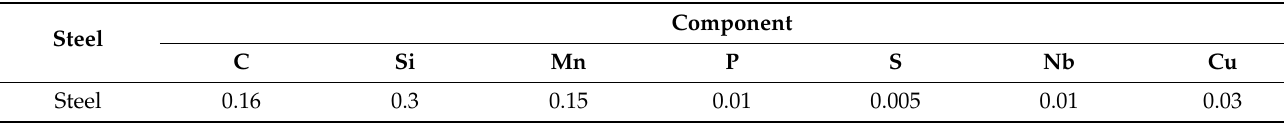
Table 6. Weight percentage of composition of Nb-added steel.